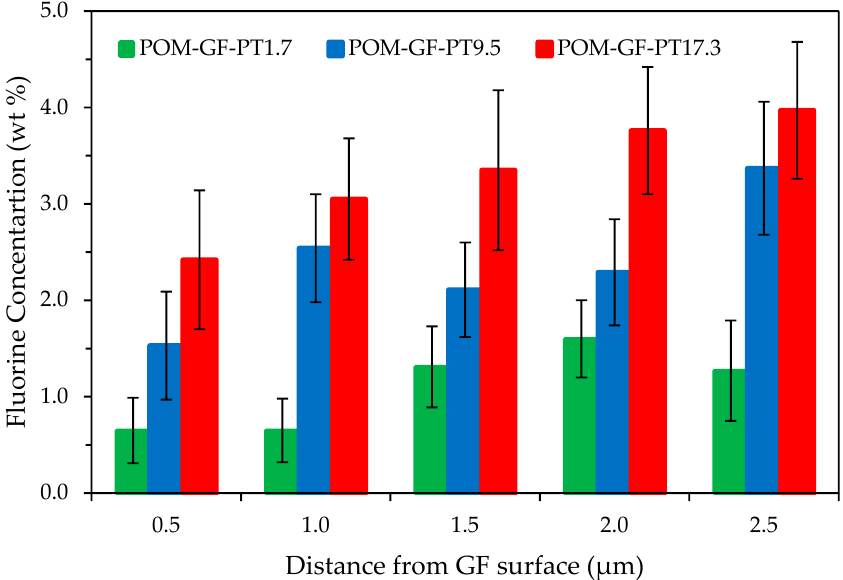
Figure 9. Weight percentage of fluorine atoms as a function of distance from GF surface.